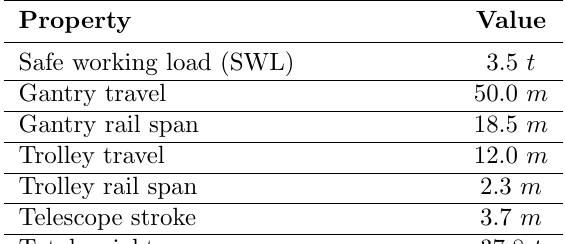
Table 2: Characteristic features of the Gantry